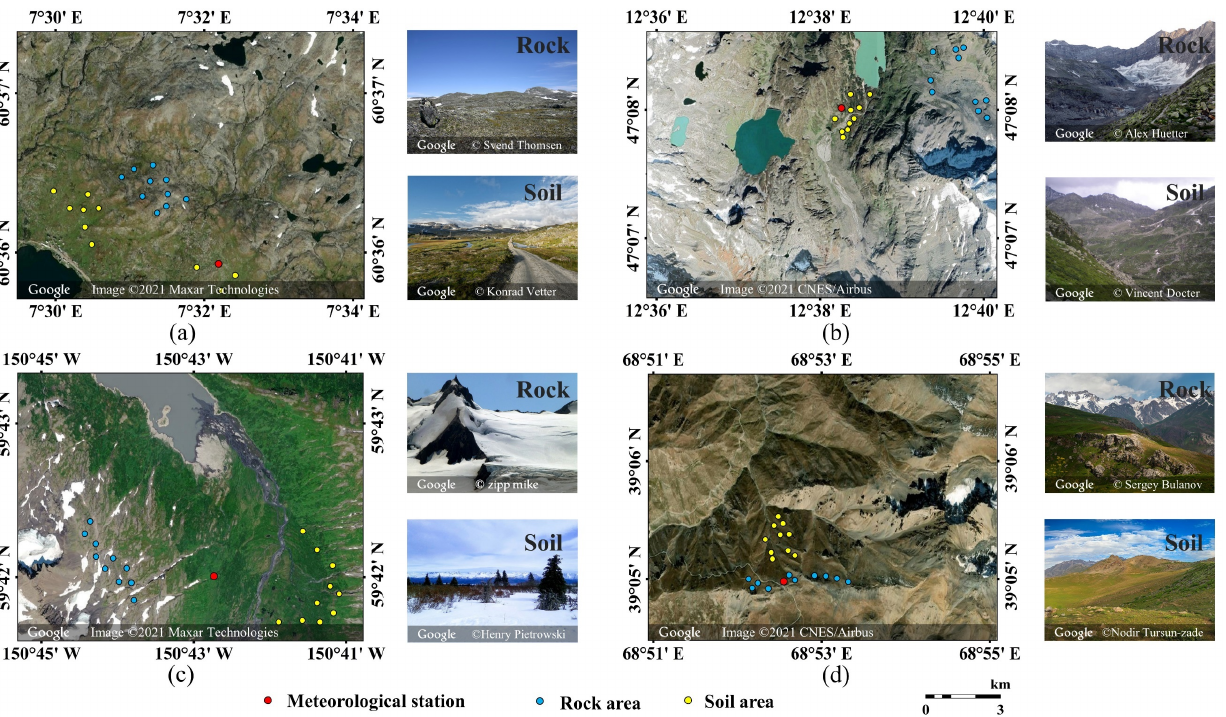
Figure 5. The specific locations of two types of feature areas within the four study areas: ( a ) FV; ( b ) RS; ( c ) NK; ( d ) AP. The blue represents rock areas, while the yellow represents soil areas. Color images and photos of the corresponding feature areas are from Google Earth Pro.